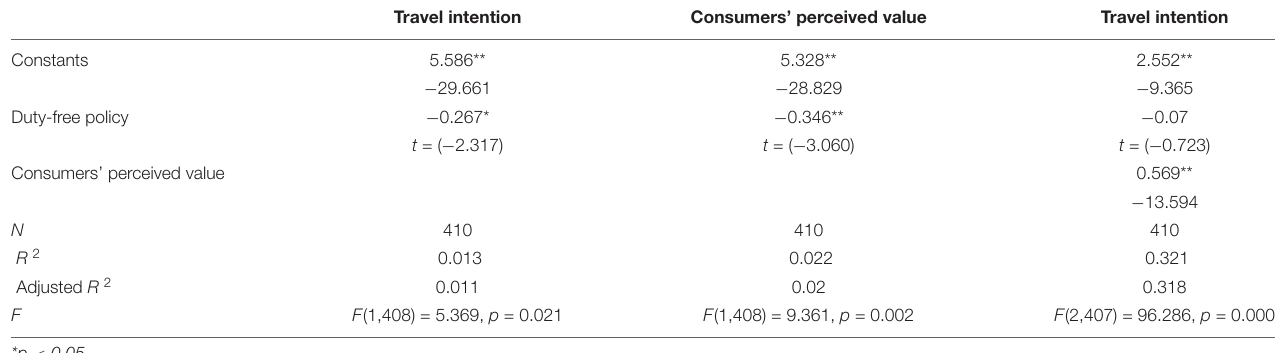
TABLE 3 | Causal stepwise regression analysis of mediating effect.